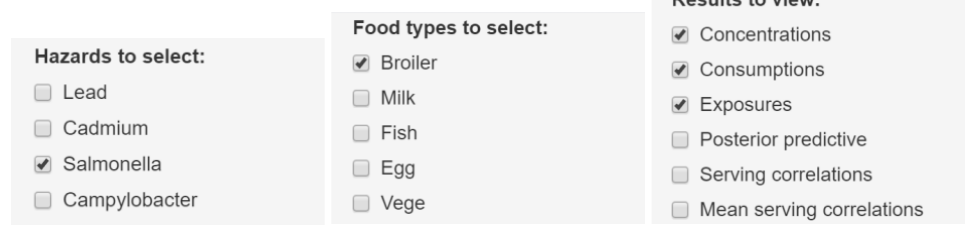
Figure 1. Example of selection tabs for hazards, foods, and results